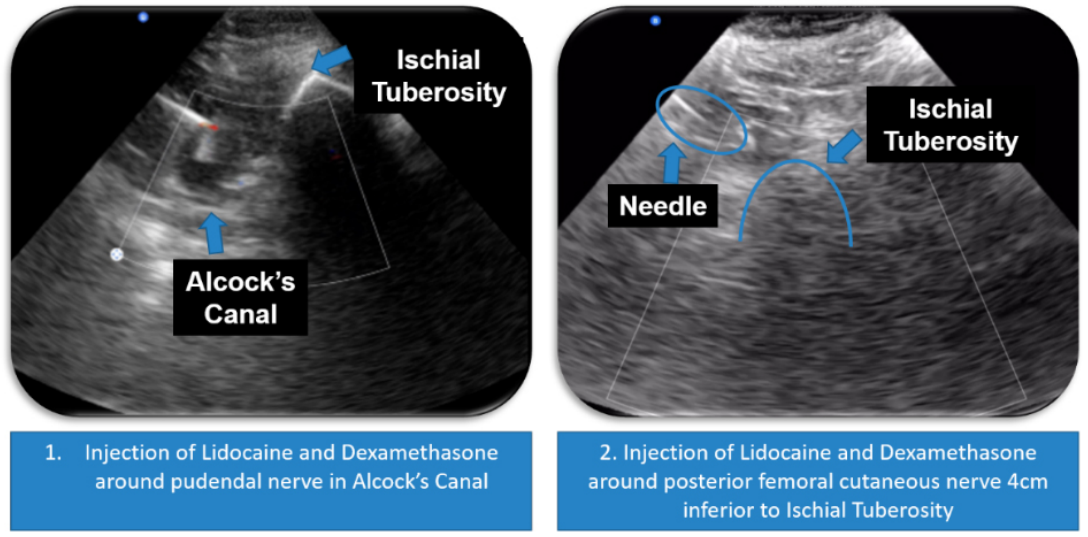
Fig. 3. Ultrasound images of Alcock’s canal and obturator canal. (1) Injection of Lidocaine and dexamethasone around pudendal nerve in Alcock’s canal. (2) Injection of Lidocaine and dexamethasone around posterior femoral cutaneous nerve 4 cm inferior to ischial